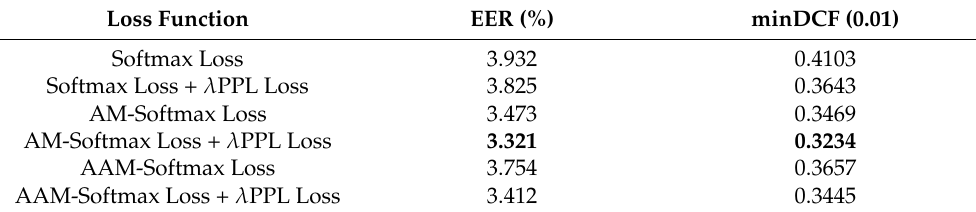
Table 4. Effect of adding PPL loss on TI-SV task on VoxCeleb. ( λ = 0.1, C =